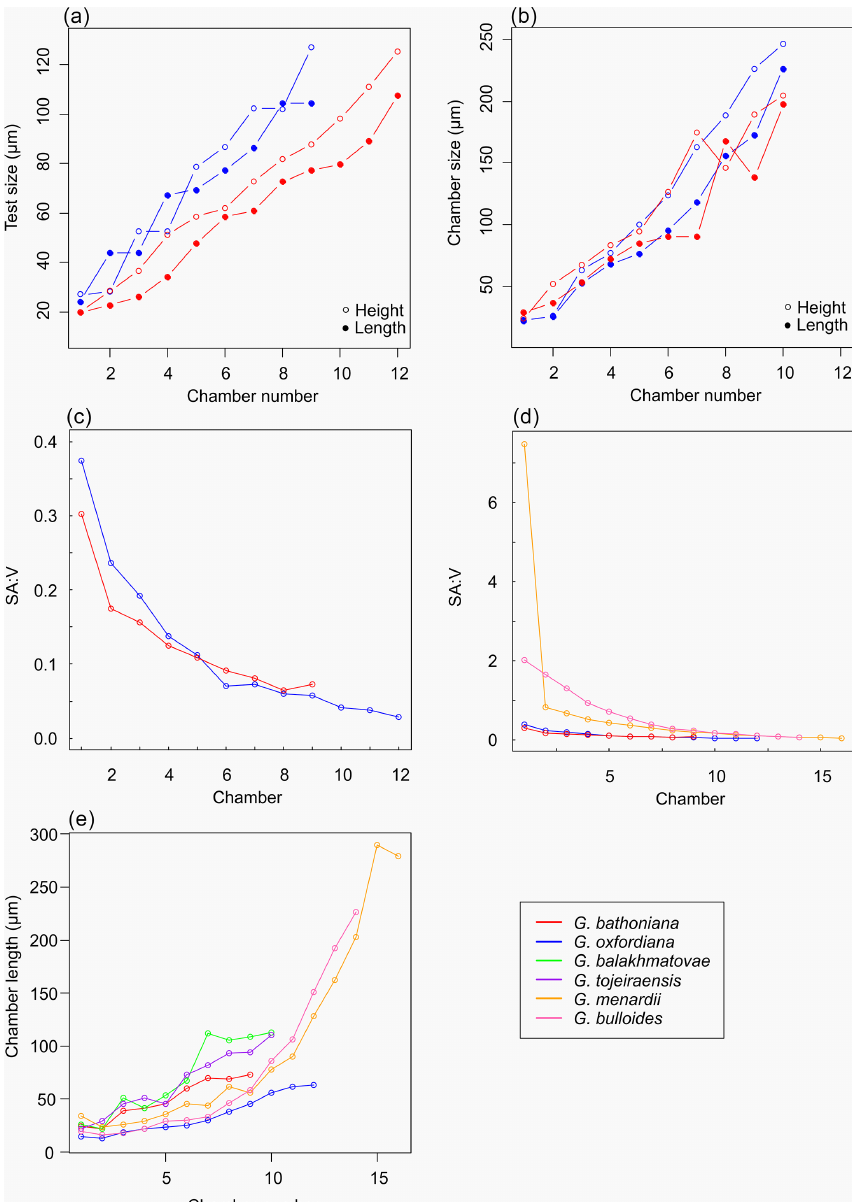
Figure 6. Morphometric growth comparisons between Jurassic species (a–c) and modern species (d–e) . Modern specimens represent a glob- ular morphology ( G. bulloides ) and more complex morphology ( G. menardii ). Jurassic species indicate more constrained growth trajectories than modern